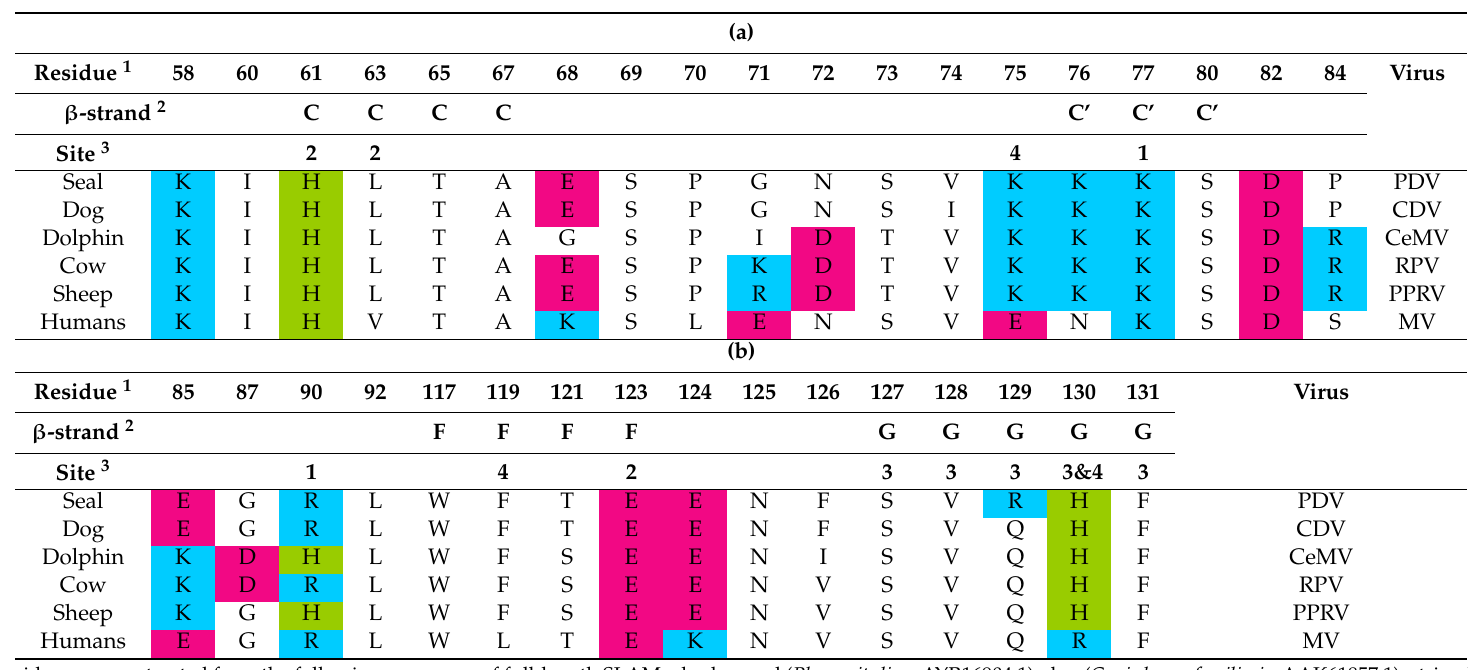
Table 3. Comparison of 35 residues at the signaling lymphocyte activation molecule (SLAM) interface potentially involved in binding to the hemagglutinin (H) proteins of the six main morbillivirus host